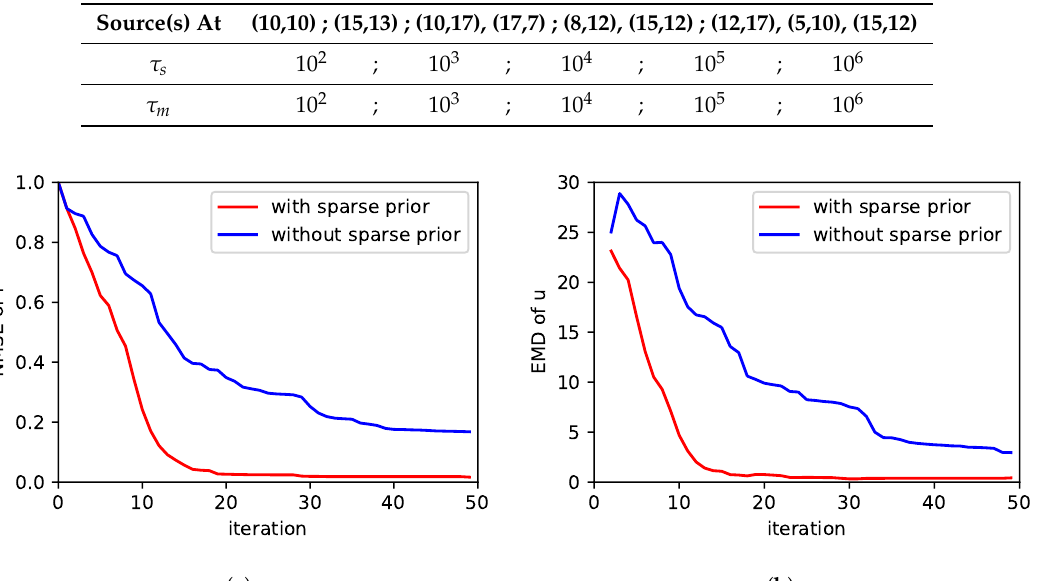
Figure 2. Comparison of the exploration performance: The two plots compare performance measures with and without the use of the sparsity assumption of the source distribution. In ( a ) the error of the estimated concentration field is shown as NMSE. In ( b ) the error of the estimated source distribution is plotted by means of the EMD. The curves are averaged over several simulation